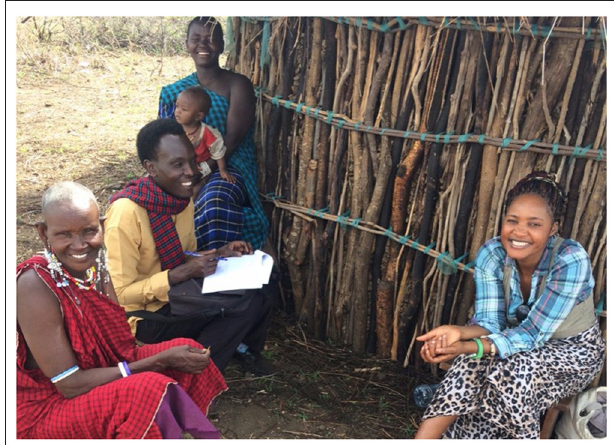
FIGURE 6 | Interview with Naisula and her mother-in-law.